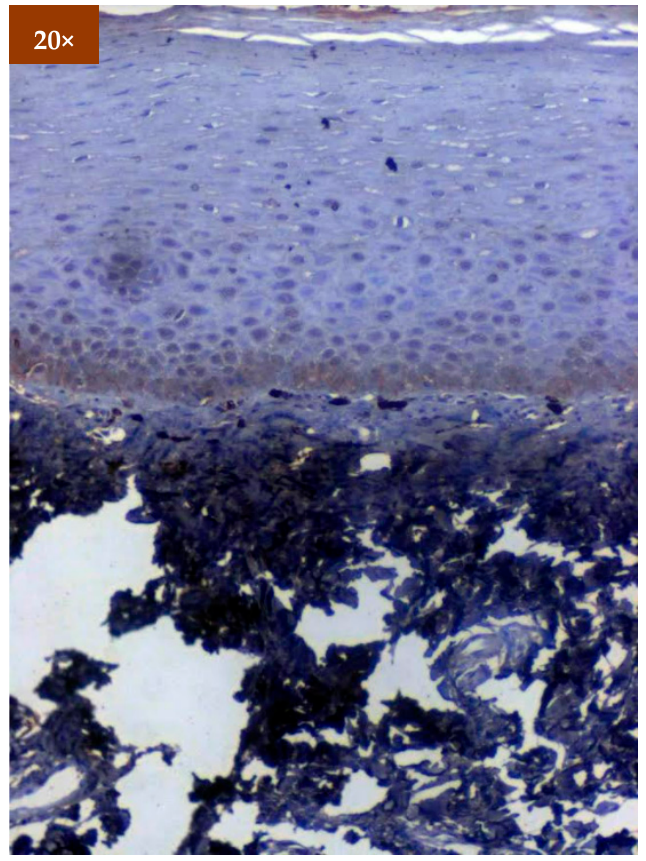
Figure 4. IHC of EGFR in OSMF samples (under 20× magnification) .